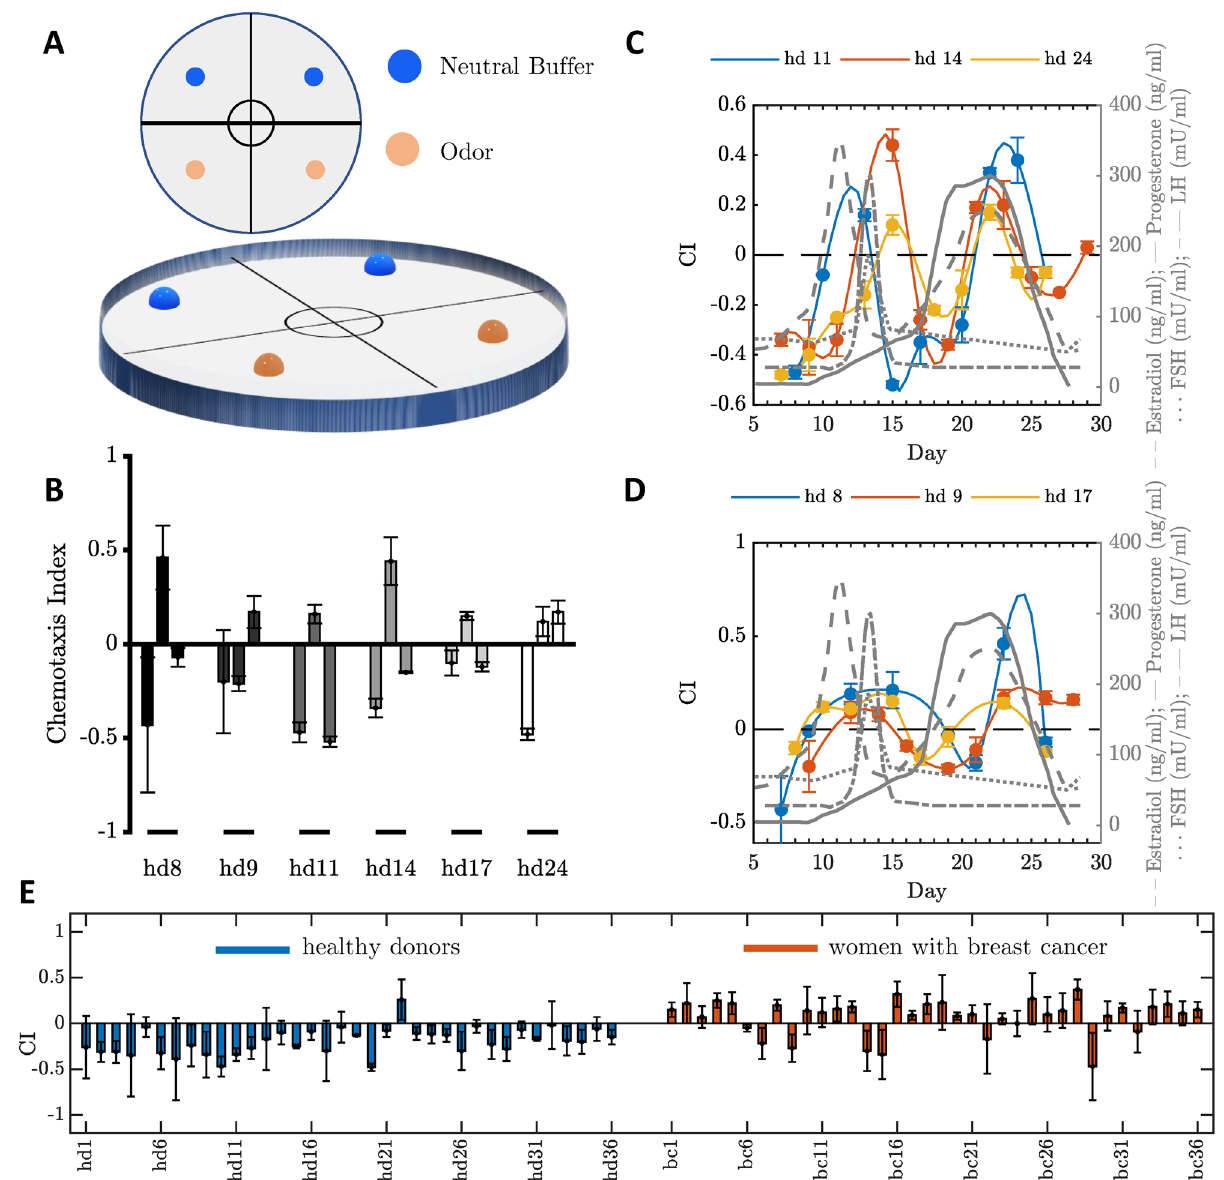
Figure 1. C. elegans chemotaxis assays with urine samples from healthy donors and cancer patients. ( A ) Population chemotaxis assay plate design. A 10 cm diameter Petri dish was used to conduct chemotaxis assays. The plate was divided into four quadrants, two odorant areas (+) and two control areas (−). One microliter of either cancer or control urine samples diluted at 10 −1 was placed on the odorant areas (+). Nematodes were placed in the center of the plates and after 60 minutes a chemotaxis index (CI) was calculated as CI = (number of worms in the odorant areas (+) - number of worms in the control areas (−)) / total number of worms. ( B ) The chemotaxis index of C. elegans is influenced by female hormones. Chemotaxis assays on urine collected from six healthy donors (hd) during different days of the month showed variability in the chemotaxis index, suggesting an influence by female hormones. Error bars indicate SEM of three independent experiments performed on the same day on separate plates ( C,D ) C. elegans responses to urine collected from healthy donors are influenced by menstrual cycle rhythmicity. Chemotaxis assays were performed using urine collected from six healthy donors (hd), three times a week, starting two days after the end of the period, until the next period. CI correlates with LH, FSH and estradiol release preceding ovulation, and the progesterone peak during the luteal phase 38 . It is worth to notice that the pre-ovulation curve is narrower in group 1 ( C ) if compared to the curve of group 2 ( D ). Error bars indicate SEM of three independent experiments carried out on the same day on different plates. In ( C , D ), we included samples provided by three volunteers who were available to collect urine samples three times a week over one month. Grey curves indicate the fluctuations of hormone release during the menstrual cycle (reference graph modified from 38 ). ( E ) Bar plot of the resulting chemotaxis index values for each sample of the control (blue bars) and positive group (red bars) reported with the corresponding standard